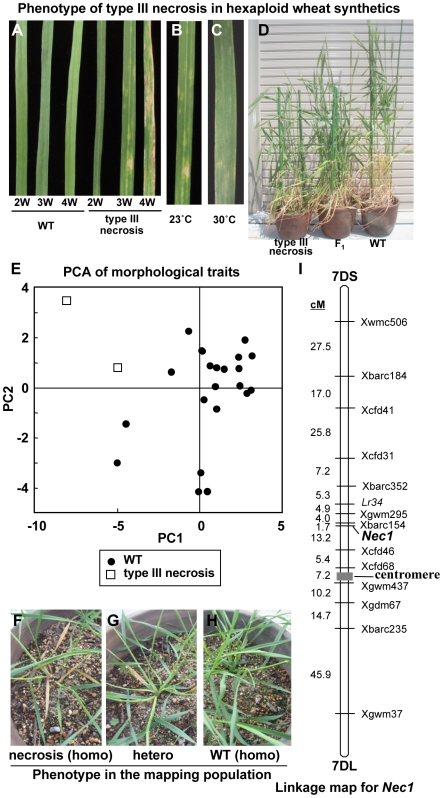
Phenotypic and genetic characterization of type III hybrid necrosis in hexaploid wheat synthetics.A) Phenotype of the 1st (lowest) leaf in WT and a type III necrosis line. From the left, 2-, 3- and 4-week-old seedlings in WT and the type III necrosis line are sequentially shown. Each plant was grown at 23°C. B-C) Leaf phenotype of the type III necrosis line grown at 23°C (B) and 30°C (C). D) Overview of type III necrosis lines. Left; type III necrosis line (synthetic wheat of Ldn and KU-2828), middle; F1 plant between the WT and type III necrosis lines, right; WT line (synthetic wheat of Ldn and KU-2075). E) Graph of the first two axes from a principal component analysis based on the 19 morphological traits in synthetic hexaploid wheat lines showing WT and type III necrosis. F) Early growth and leaf phenotype of type III necrosis line (synthetic wheat of Ldn and KU-2828). G) Early growth and leaf phenotype of F1 plant between WT and type III necrosis line. H) Early growth and leaf phenotype of the WT line (Ldn x KU-2075). I) Genetic linkage map for Nec1 on chromosome 7D. Genetic distances (cM) and markers are shown on the left and right, respectively.